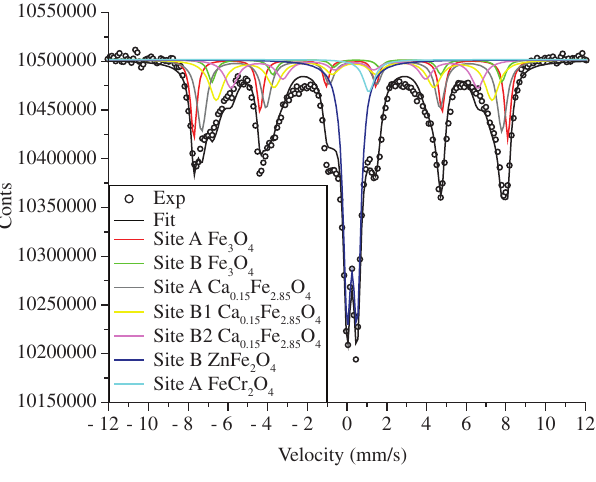
Figure 4. Möss�a�er spectr�m o� sample 2.